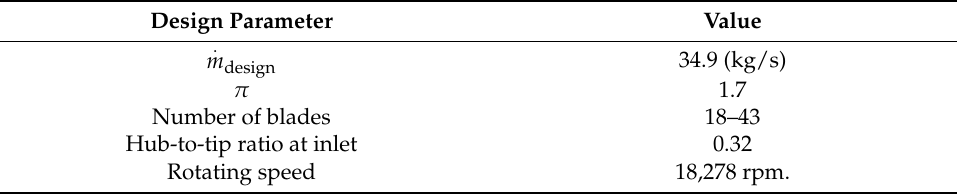
Figure 1. 3D and meridian surface diagram of the baseline fan. Table 1. Key geometric and aerodynamic parameters of the baseline fan.